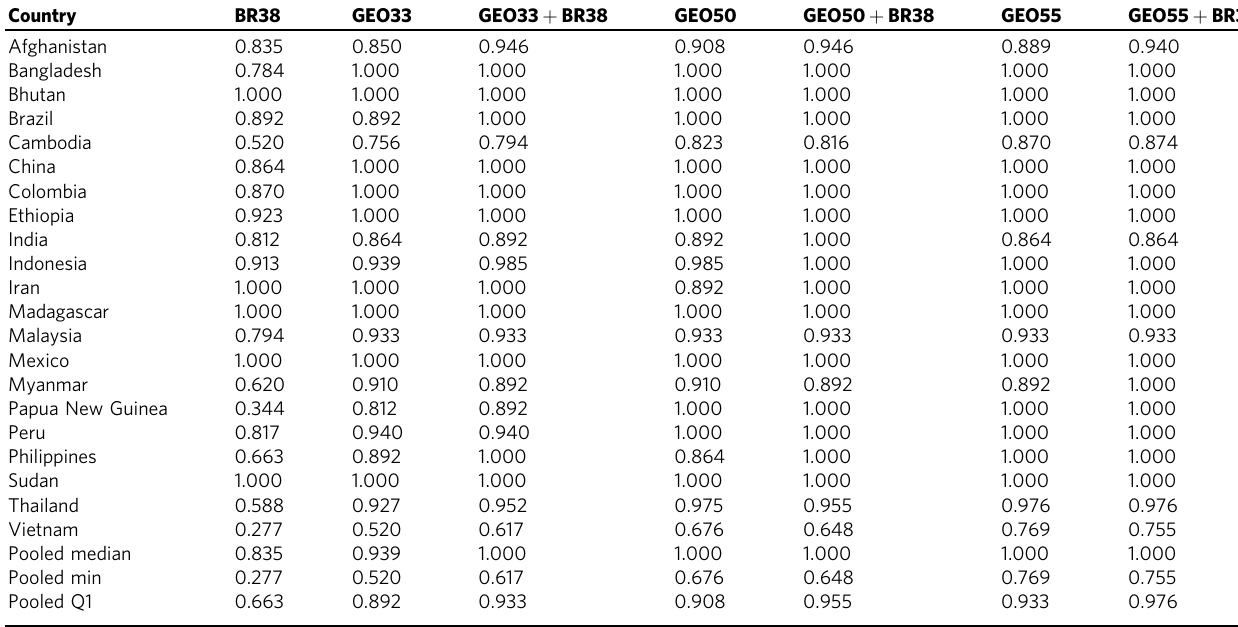
Table 1 Summary of MCC scores from the results of 500 repeats of the strati fi ed 10-fold cross-validation of the SNP panels.